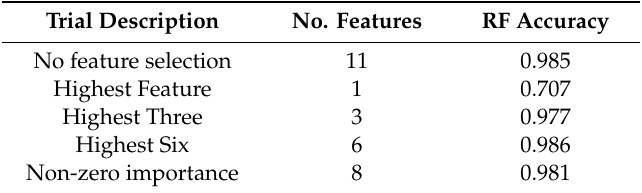
Table 5. RF Accuracies Using Di ff erent Features Based on Their